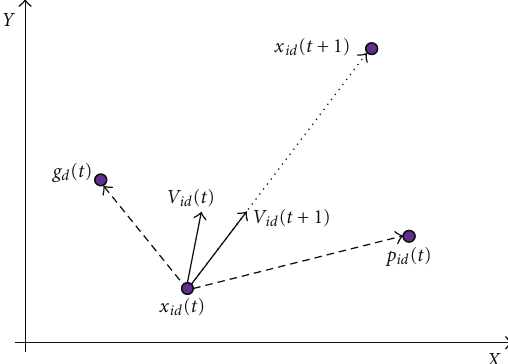
Figure 1: Position and velocity update of i th particle in the